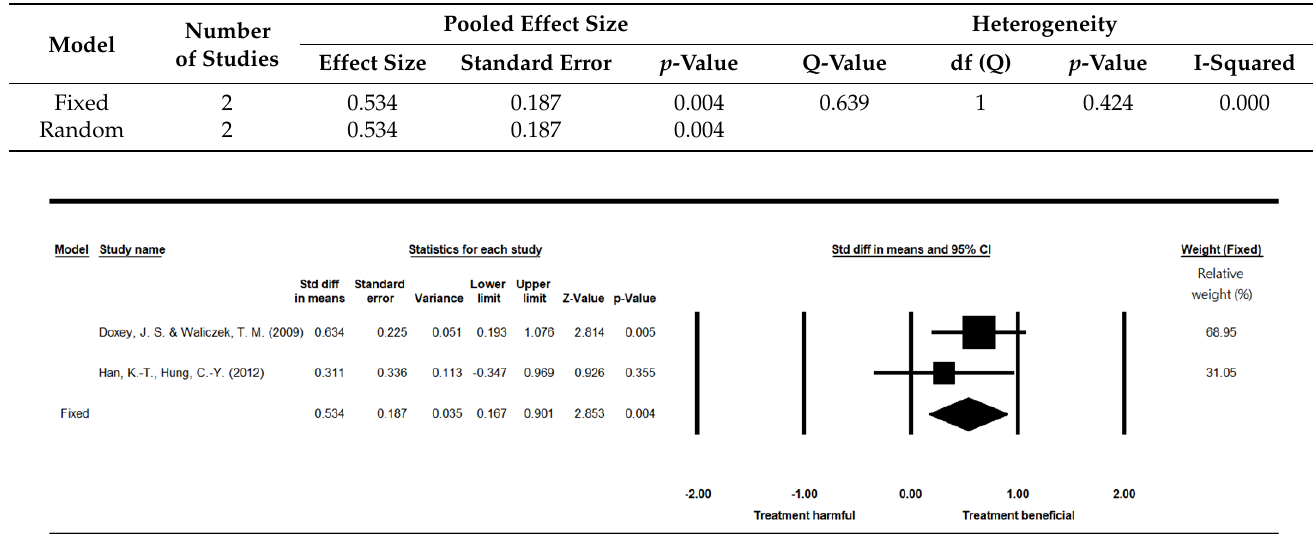
Figure 6. Forest plot of studies on the influence of indoor plants on academic achievement [66,86].